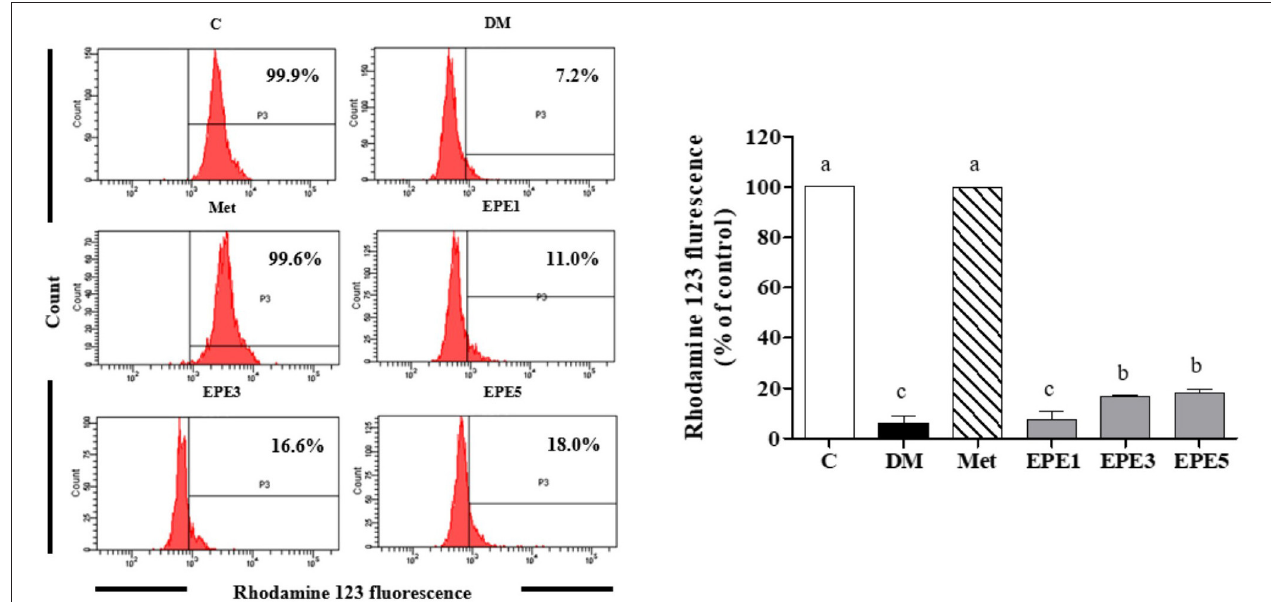
FIGURE 8 | The levels of mitochondria membrane potential (MMP) of sperm in diabetic rats after 4 weeks of treatments. Data are shown as the mean ± SEM ( n = 6). The values with different superscript letters (a–c) represent significant differences ( p < 0.05) as analyzed by Duncan’s multiple range test. C, control; DM, diabetes mellitus; Met, metformin; EPE, Echinacea purpurea ethanol extract.